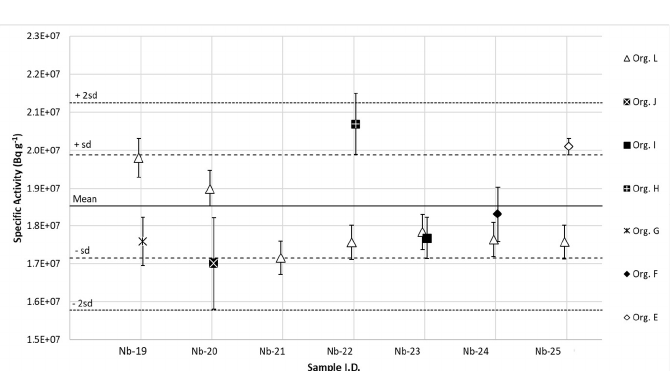
Fig. 3 93m Nb Specific activity measurements obtained for B.3,1mg strip with 19.6 ppm Ta Fig. 4 93m Nb Specific activity measurements obtained for B.4, 8mg disk with 0.3 ppm Ta